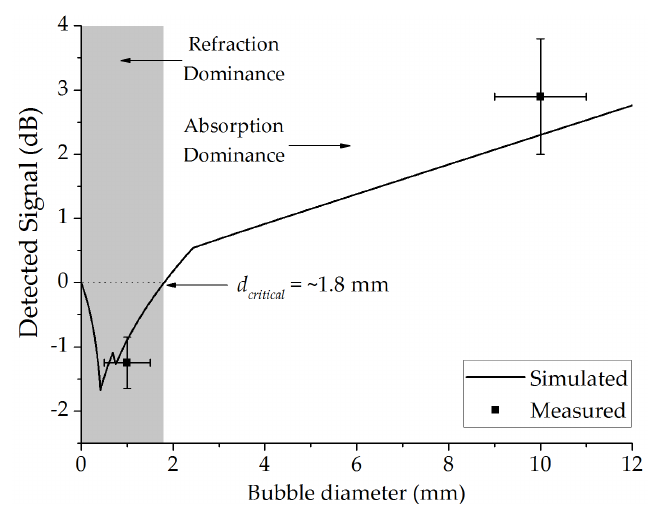
Figure 5. Detected signal as a function of the bubble diameter.